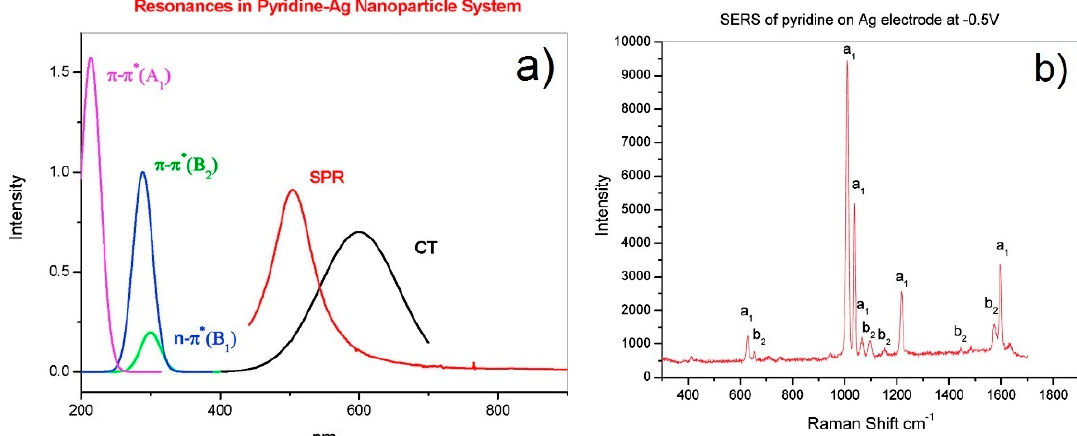
Figure 5. ( a ) Spectral distribution of the plasmonic (red line), charge transfer (CT, black line), and intramolecular (green, blue, and violet lines) resonances for pyridine adsorbed on silver. Reprinted (adapted) with permission from Lombardi et al. [9]. Copyright (2008) American Chemical Society. ( b ) SERS spectrum of pyridine on silver. Reprinted (adapted) with permission from Lombardi et al. [137]. Copyright (2008), American Chemical Society.